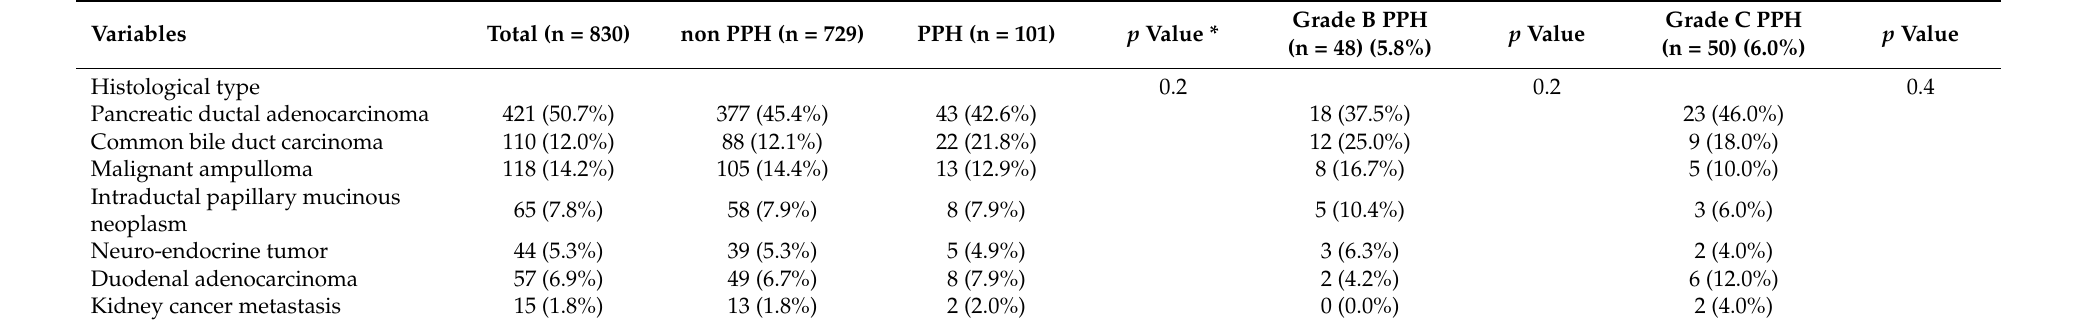
Table 3. Histological characteristics of the PPH (n = 101) and non-PPH (n = 729) groups (* Chi-squared test, ? Student t -test). Grade B and C PPH groups are compared to the non-PPH group (with only 3 patients, the grade A PPH group does not appear in the